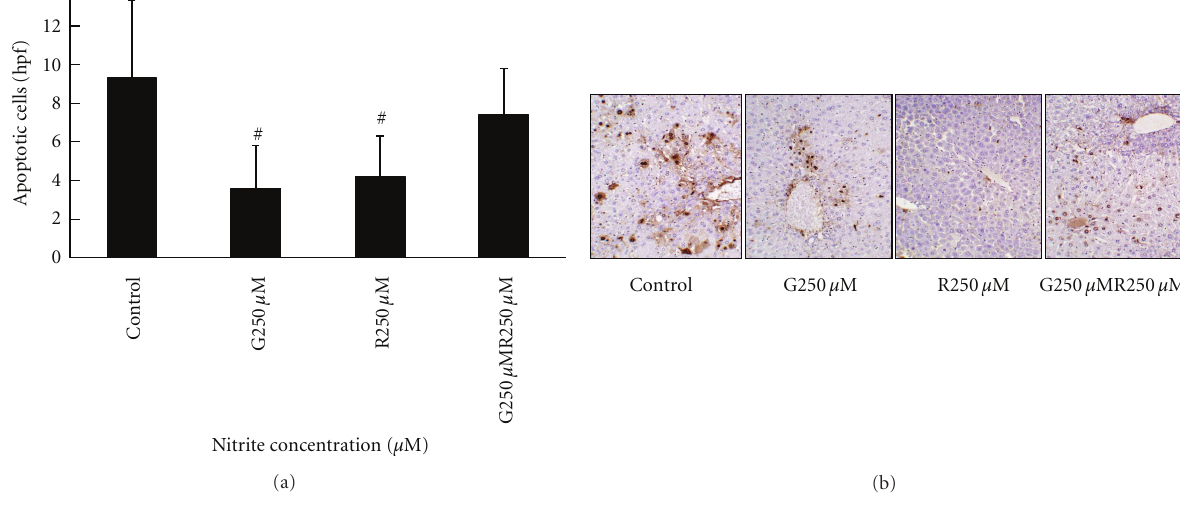
Figure 10: Nitrite reduced hepatocellular apoptosis in the donor liver graft and in the recipient after liver transplantation. Hepatocellular apoptosis was significantly reduced by anion nitrite in the donor liver graft and recipient only groups compared to control and combined treatment groups 3 hours posttransplantation (9 . 8 ± 4 . 1 versus 3 . 9 ± 2 . 4 versus 4 . 1 ± 2 . 6 versus 7 ± 3 . 9). Data are expressed as mean ± SE. # P < 0 . 05 for corresponding